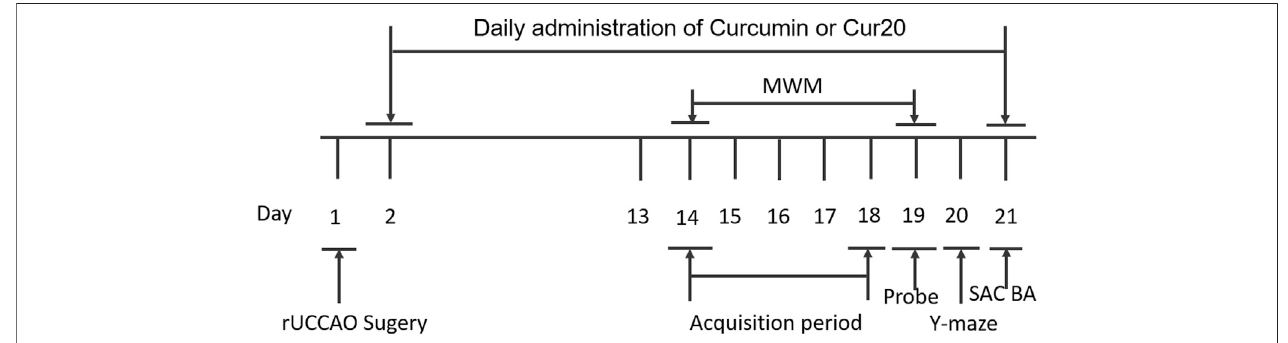
FIGURE 2 | Experimental schedule for in vivo experiment. The mice were randomly divided into four groups: sham control group; VaD model group; curcumin group; and Cur20 group. rUCCAO, right unilateral common carotid arteries occlusion; MWM, Morris water maze; SAC, sacri fi ce; BA, biochemical